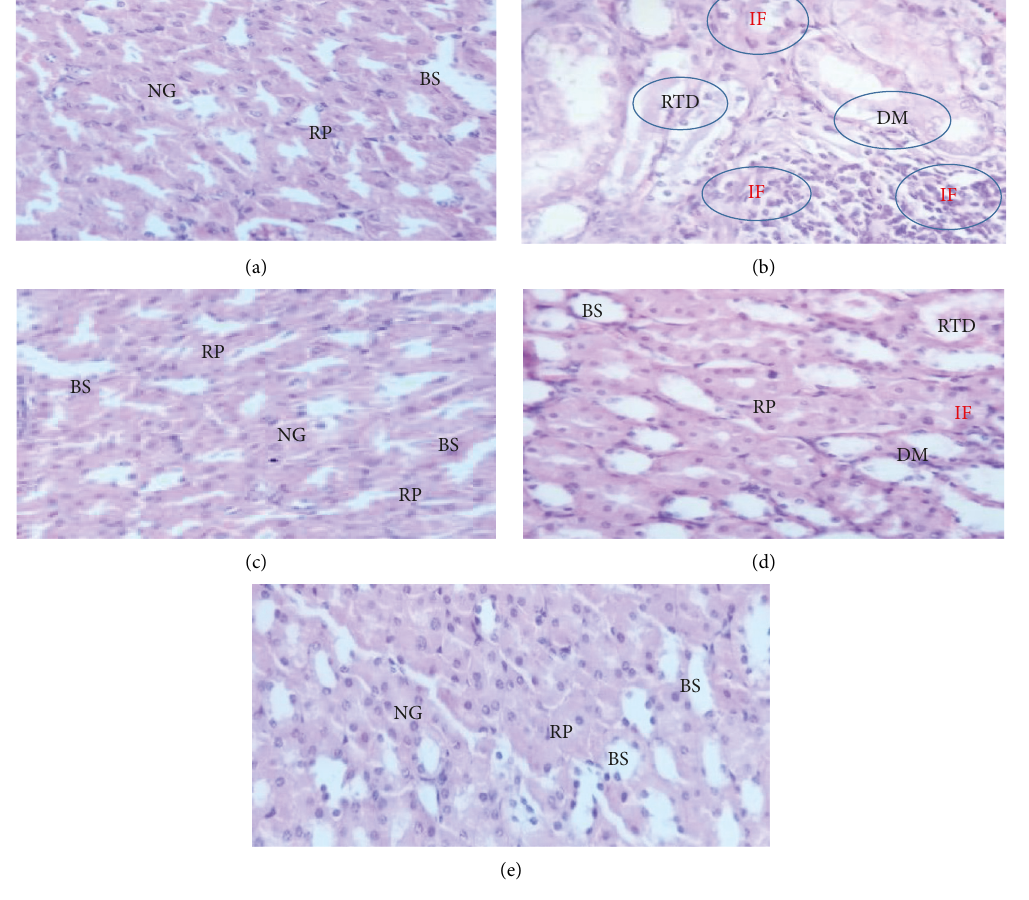
Figure 1: Photomicrograph of kidney section of animal (40x, stained with hematoxylin and eosin): group I (a), group II (b), group III (c), group IV (d), and group V (e). BS, Bowman’s space; DM, damage of glomerulin; IF, inflammatory infiltration; NG, normal glomeruli; RP, renal parenchyma; and RTD, renal tubule